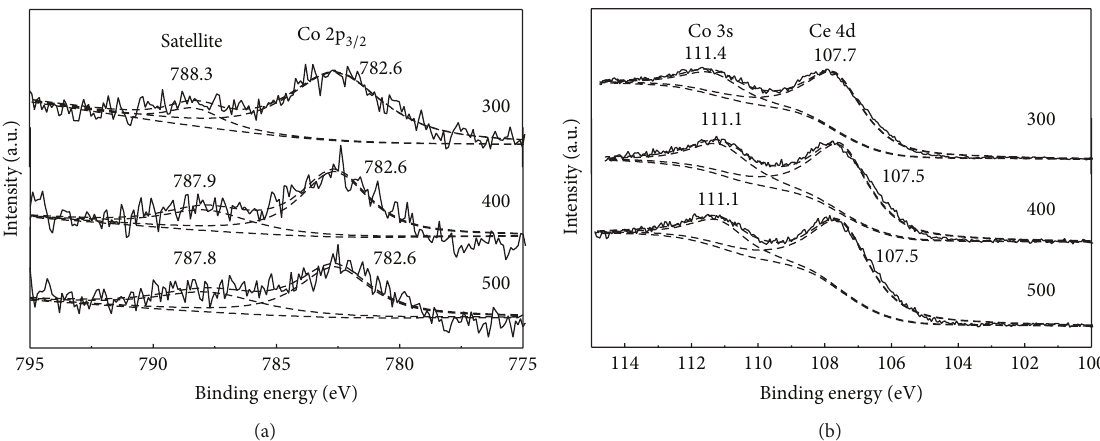
Figure 9: XPS spectra of (a) the Co 2p region and (b) the Co 3s-Ce 4d region for 5wt.% Co 3 O 4 /CeO 2 prepared by calcining the spontaneous combusted precursor at temperatures 300 ∘ C, 400 ∘ C, and 500 ∘ C.